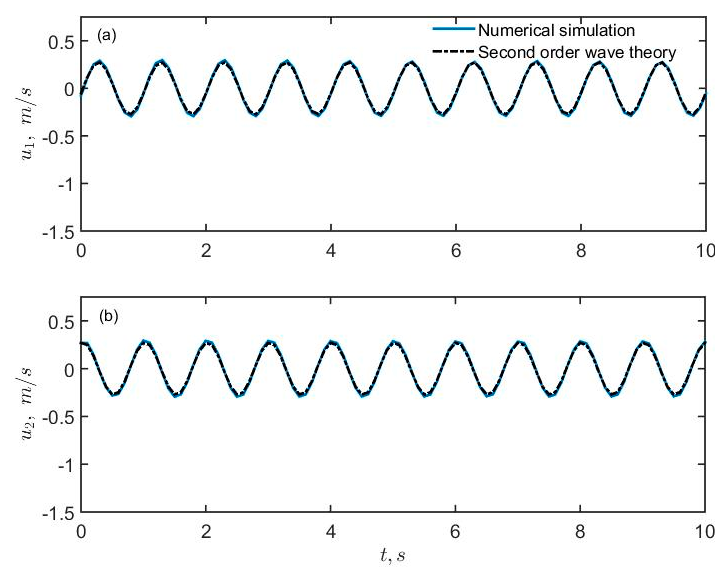
Figure 3. Instantaneous contours of vertical ( top ) and horizontal ( bottom ) velocities after the fl ow is fully developed. Horizontal velocity is positive to the right and vertical velocity is positive upward.